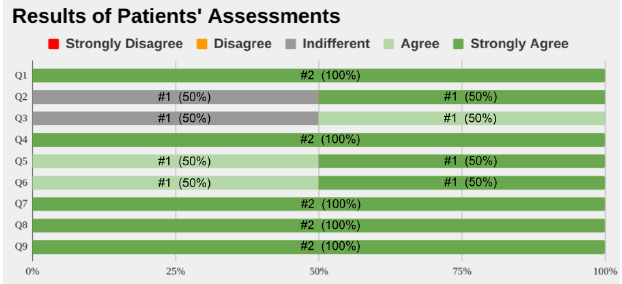
Figure 14. The patient’s results summarized. Source: Author (2022).